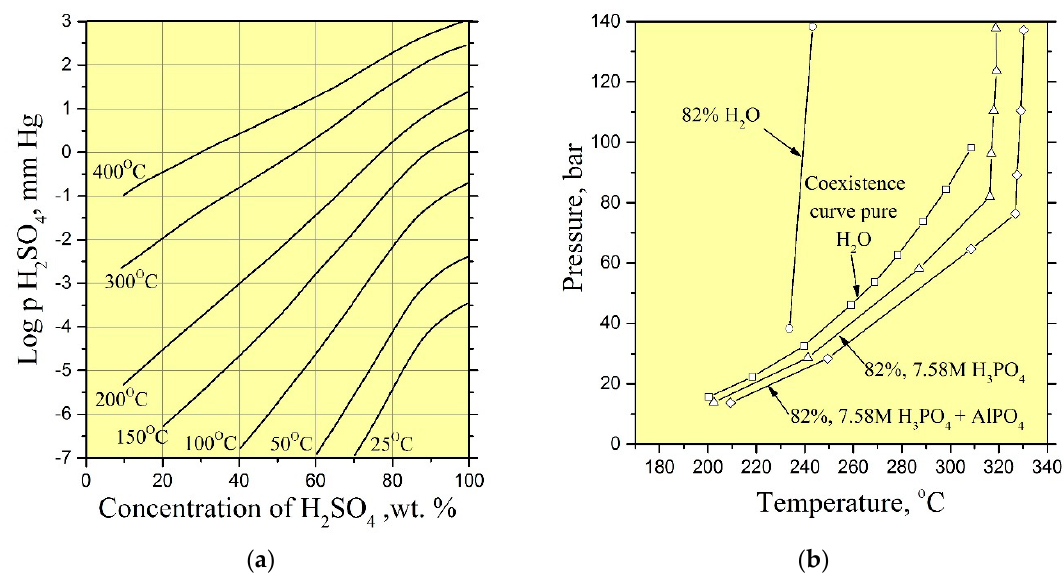
Figure 13. ( a ) Partial pressure of H 2 SO 4 over aqueous sulfuric acid [37]; ( b ) pressure versus temperature